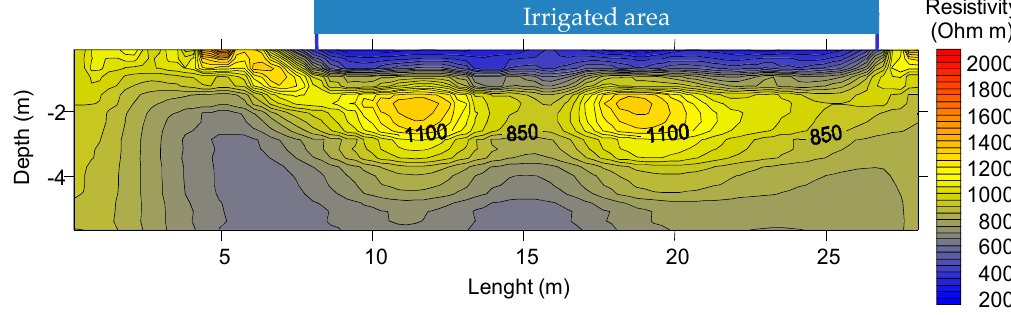
Figure 8. Grugliasco site, 28 August 2009 (hour 17:30). Absolute ERT image at the end of irrigation along the longitudinal ERT line (see Figure 3 for location).